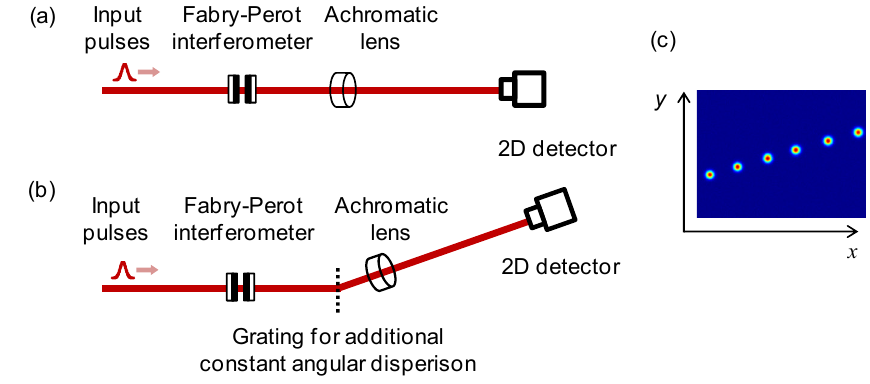
Figure 14. Typical layout for simple, two-dimensional detection of propagation dispersion angular dispersion ( a ). If the original beam is not angularly dispersed enough to separate the peaks, an additional grating or prism can be inserted to have a well-known constant bias in the angular dispersion ( b ). On the right side, a sample image is shown ( c